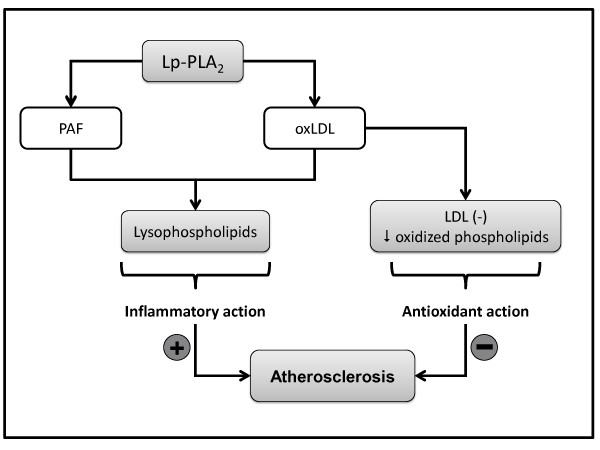
Lp-PLA2 action on cardiovascular disease.